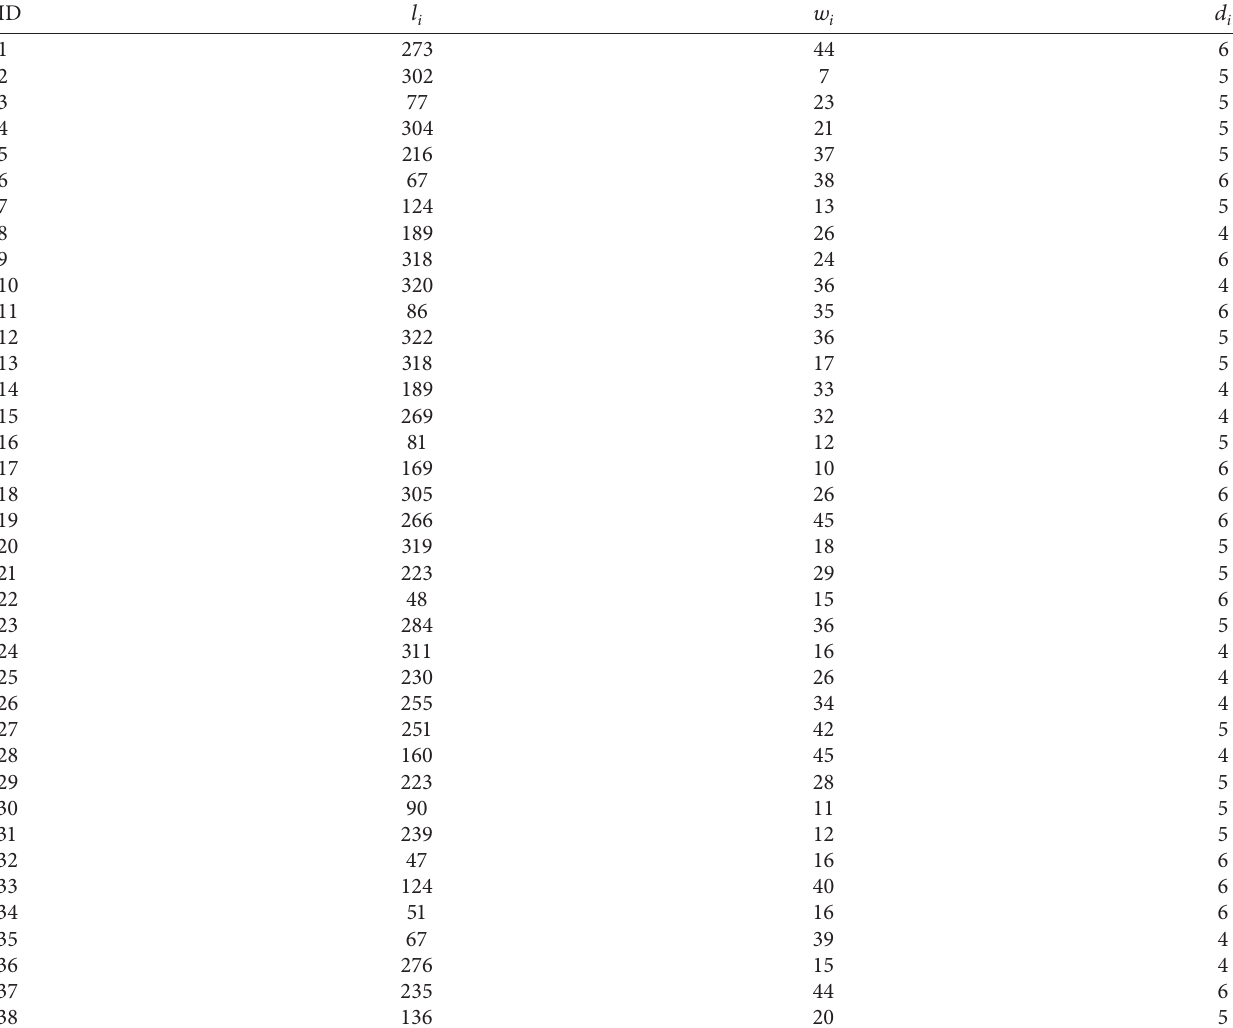
Table 4: Detailed data information of all demand